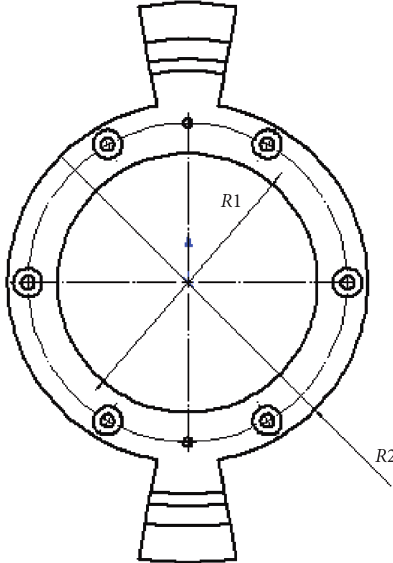
Figure 18: Structure diagram of the driven plate.